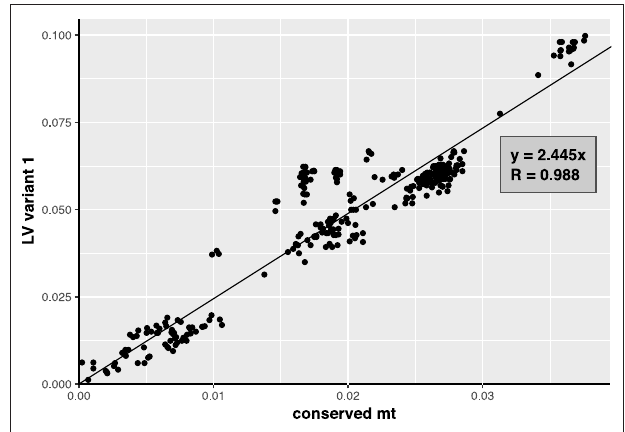
FIGURE 5 | Variant 1 of the LV region plotted against the mean genetic distance. The plot of genetic distance between strains based on variant 1 of LV-region against conserved mt region with trend line. Function of the trend line and R are shown on the